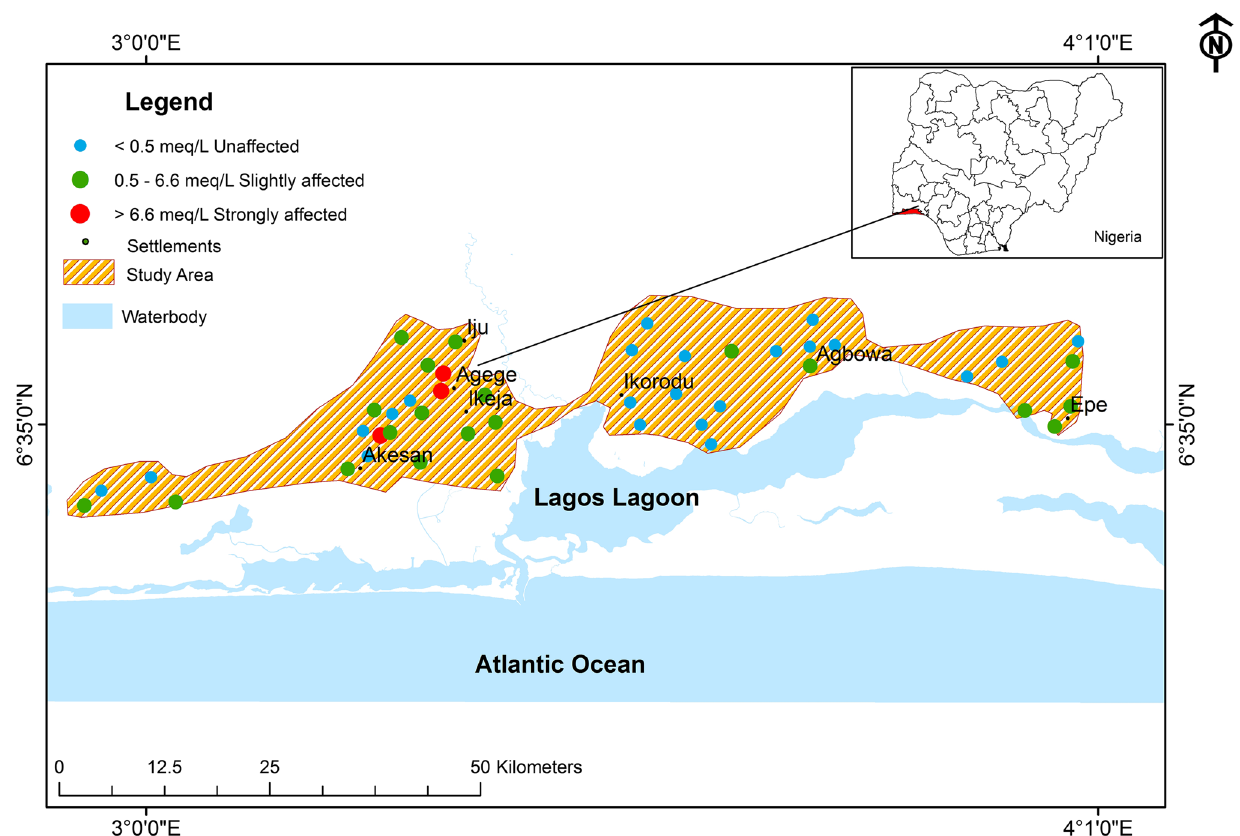
Fig. 7 Distribution of Revelle index in the wet